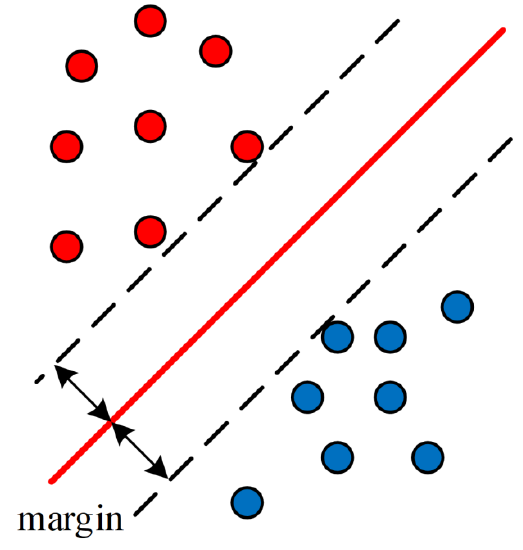
Figure 9. Maximum margin hyperplane.